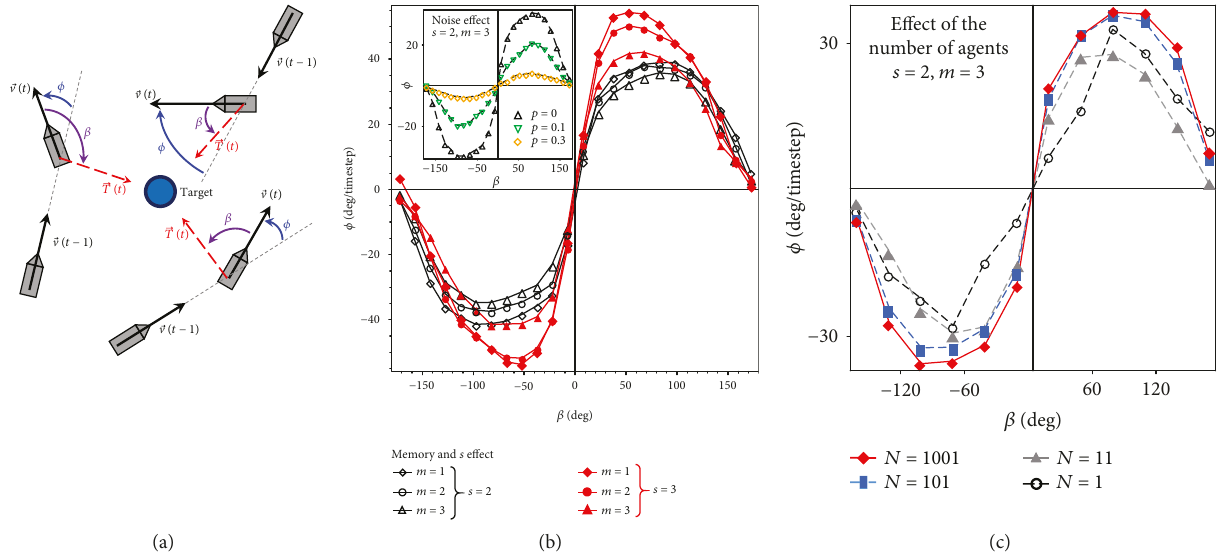
Figure 3: (a) System reorientation as it moves toward the target. The angle ϕ indicates the change in the velocity direction in one timestep, while β is the angle between v and T . The sign in the angles follows the right-hand rule. (b) Our model ’ s results for the average dependence of β on ϕ for m = 1, 2, 3 and s = 2, 3 . Inset shows the e ff ect of noise on the global outcome information: speci fi cally, each agent has a probability p of getting wrong information about the winning group. For these cases, the population is set as N = 101 agents. (c) Same as (b) but looking at a di ff erent number of agents, N , for m = 3 and s = 2 . For all cases δ = π /2 N .